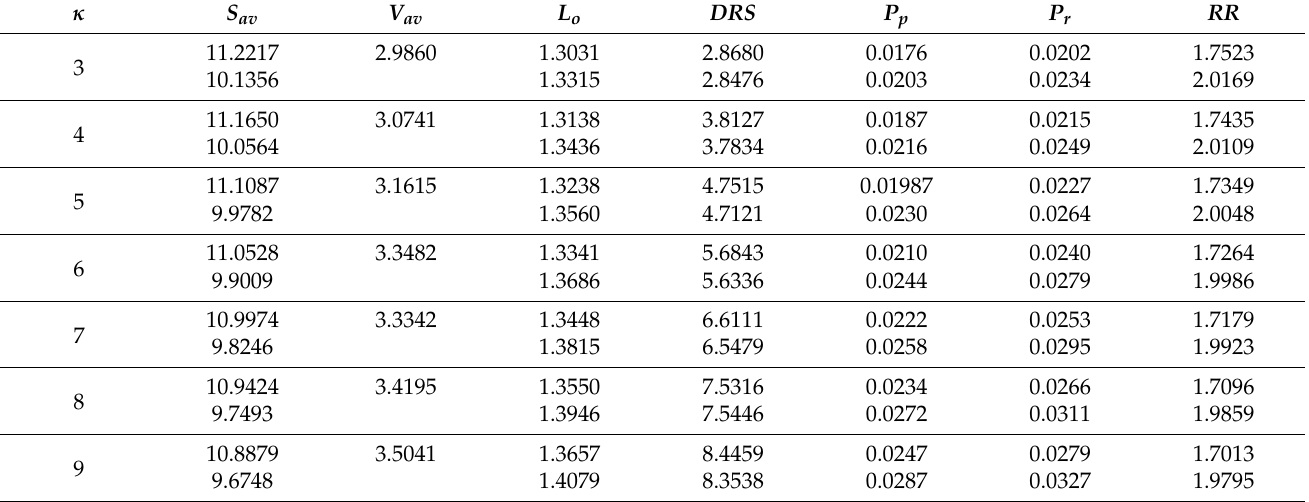
Table 3. Dependence of performance measures on parameter κ ; λ = 20, η = 15, ν = 10, α = 0.4, β = γ =